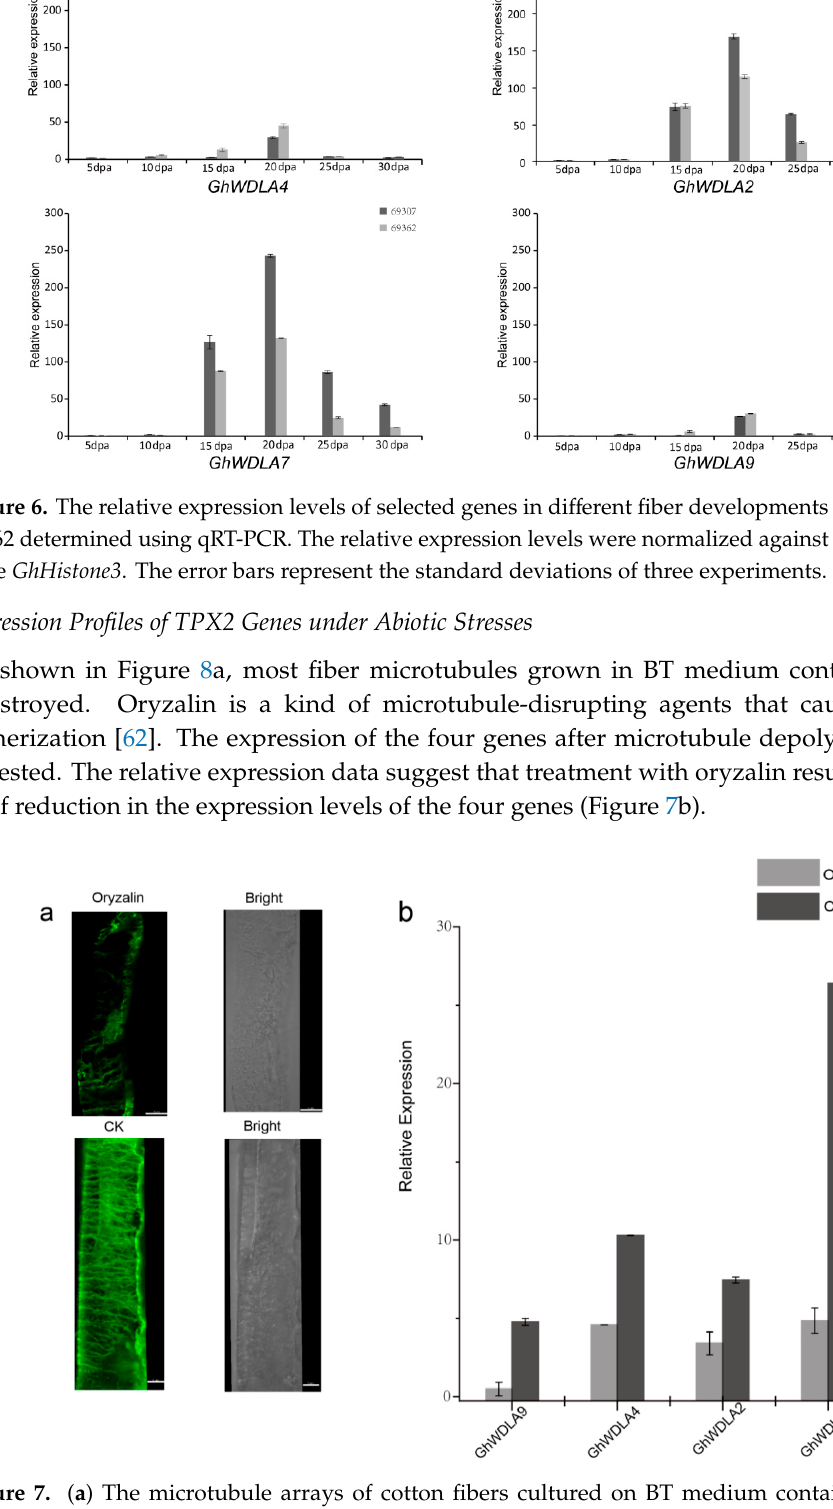
Figure 7. ( a ) The microtubule arrays of cotton fibers cultured on BT medium containing 10 µ M oryzalin: ( b ) Expression patterns of GhTPX2 genes ( GhWDLA2, 4, 7, and 9 in the cotton fibers at 18 days post anthesis (DPA) after microtubules (MTs) under oryzalin). The relative expression levels are shown against the reference gene GhHistone3 . The error bars represent the standard deviations of three